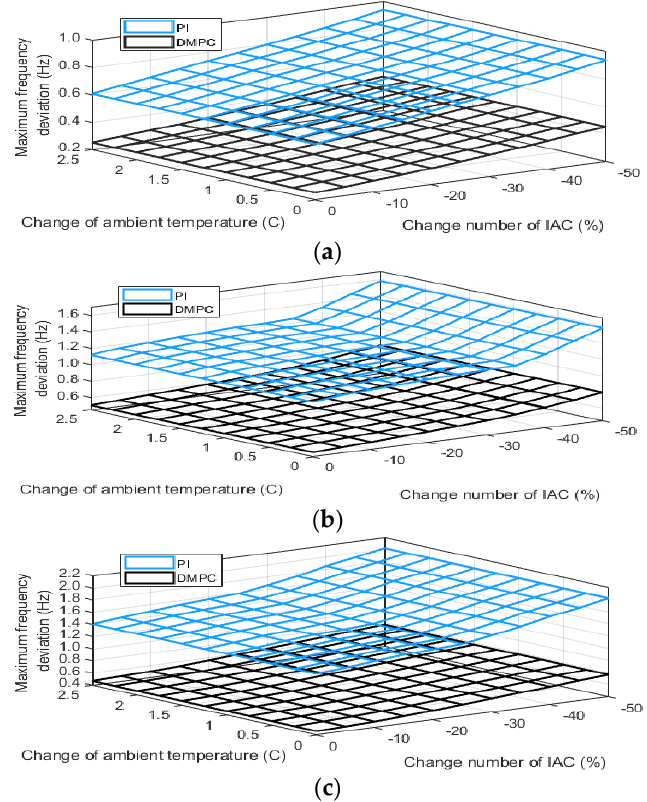
Figure 18. Absolute maximum frequency deviation when system parameters change: ( a ) case 1, ( b ) case 2, and ( c ) case 3.